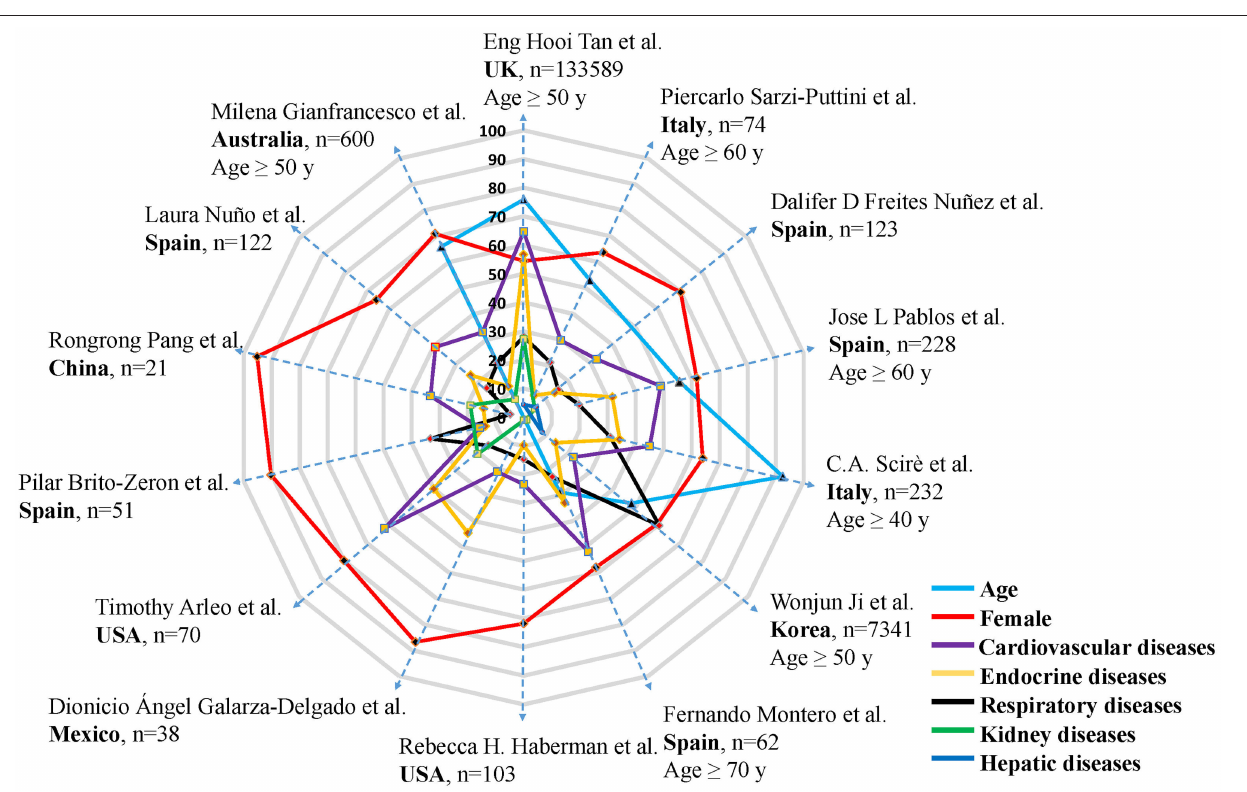
cognition on disease nursing, therapy adjustment and follow-up, especially in areas with a high COVID-19